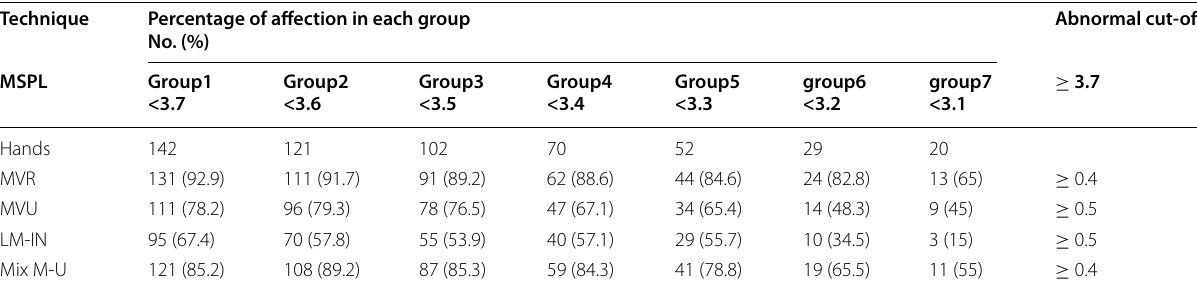
MSPL , median sensory peak latency; MVR , median versus ulnar sensory study; MVU , median versus ulnar sensory study; LM-IN , median versus ulnar lumbrical‑ interossei motor study; Mix M-U , median versus ulnar palmar mixed nerve study